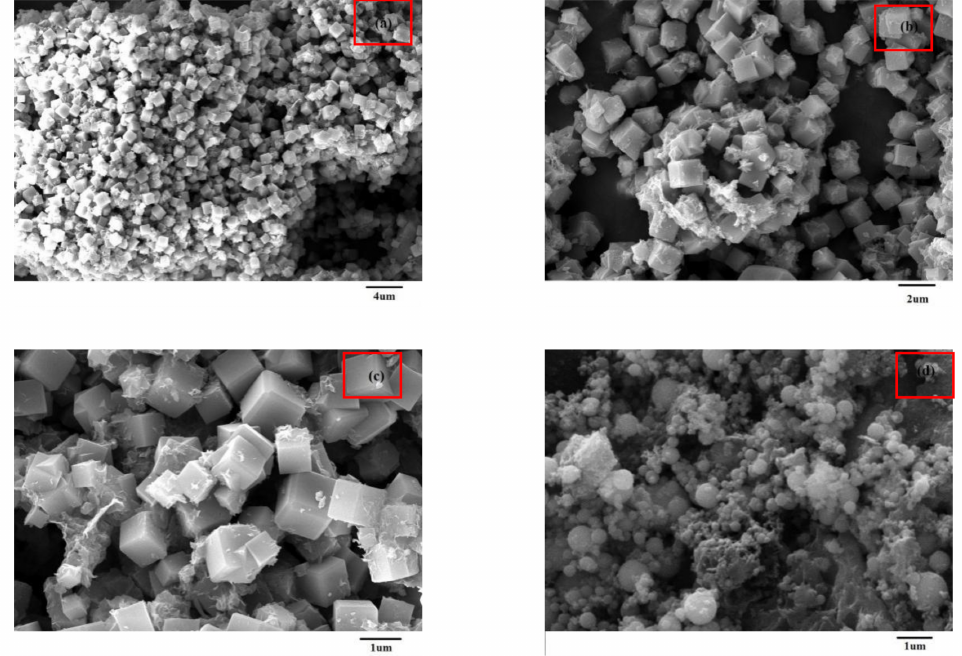
Figure 10. SEM image of fine coal gasification slag and solid-phase synthesis of zeolite. ( a – d ) are zeolite-A in di ff erent magnification.